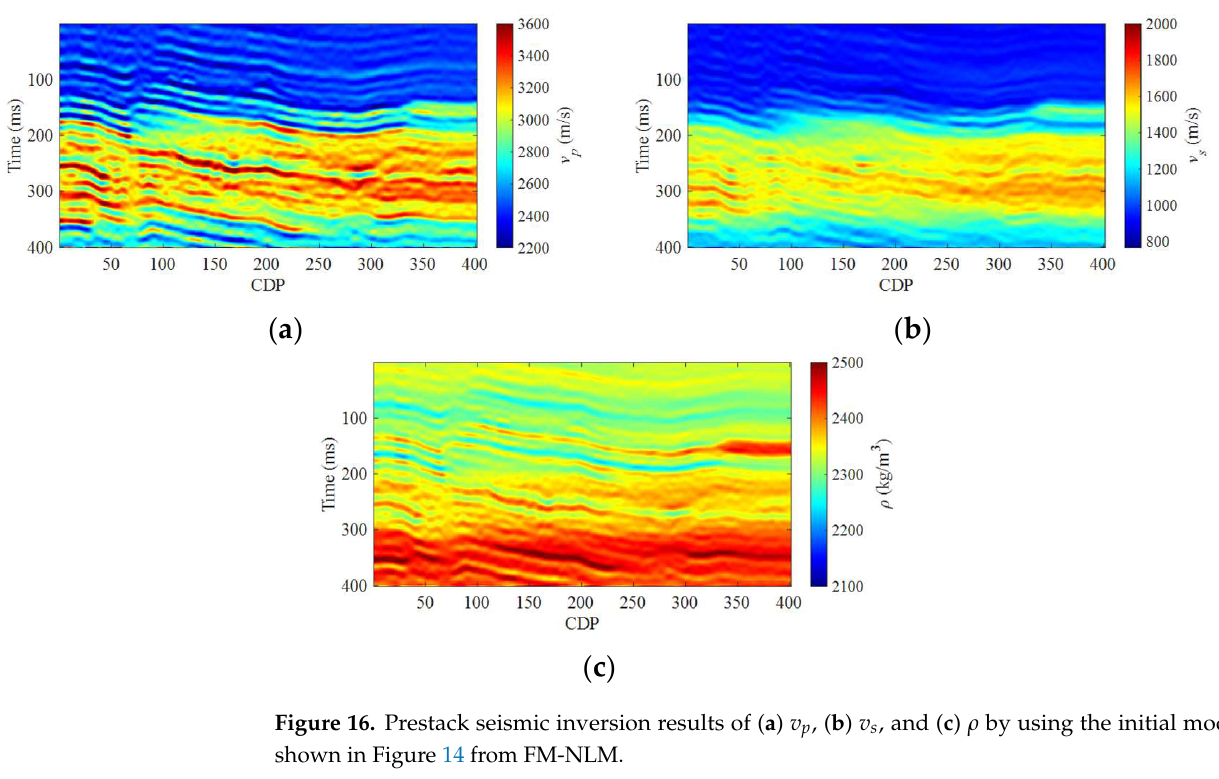
Figure 15. Prestack seismic inversion results of ( a ) v p , ( b ) v s , and ( c ) ρ by using the initial models shown in Figure 13 from KI.